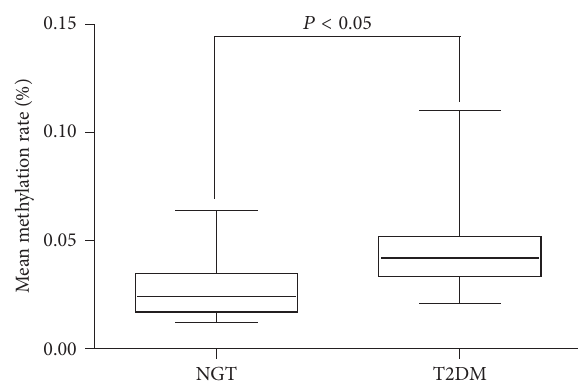
Figure 4: The DNA methylation levels of FOSL2 in NGT and T2DM groups. The mean methylation levels in 100 samples between two groups were determined by MassARRAY and the data are presented as mean ± standard deviation (SD).